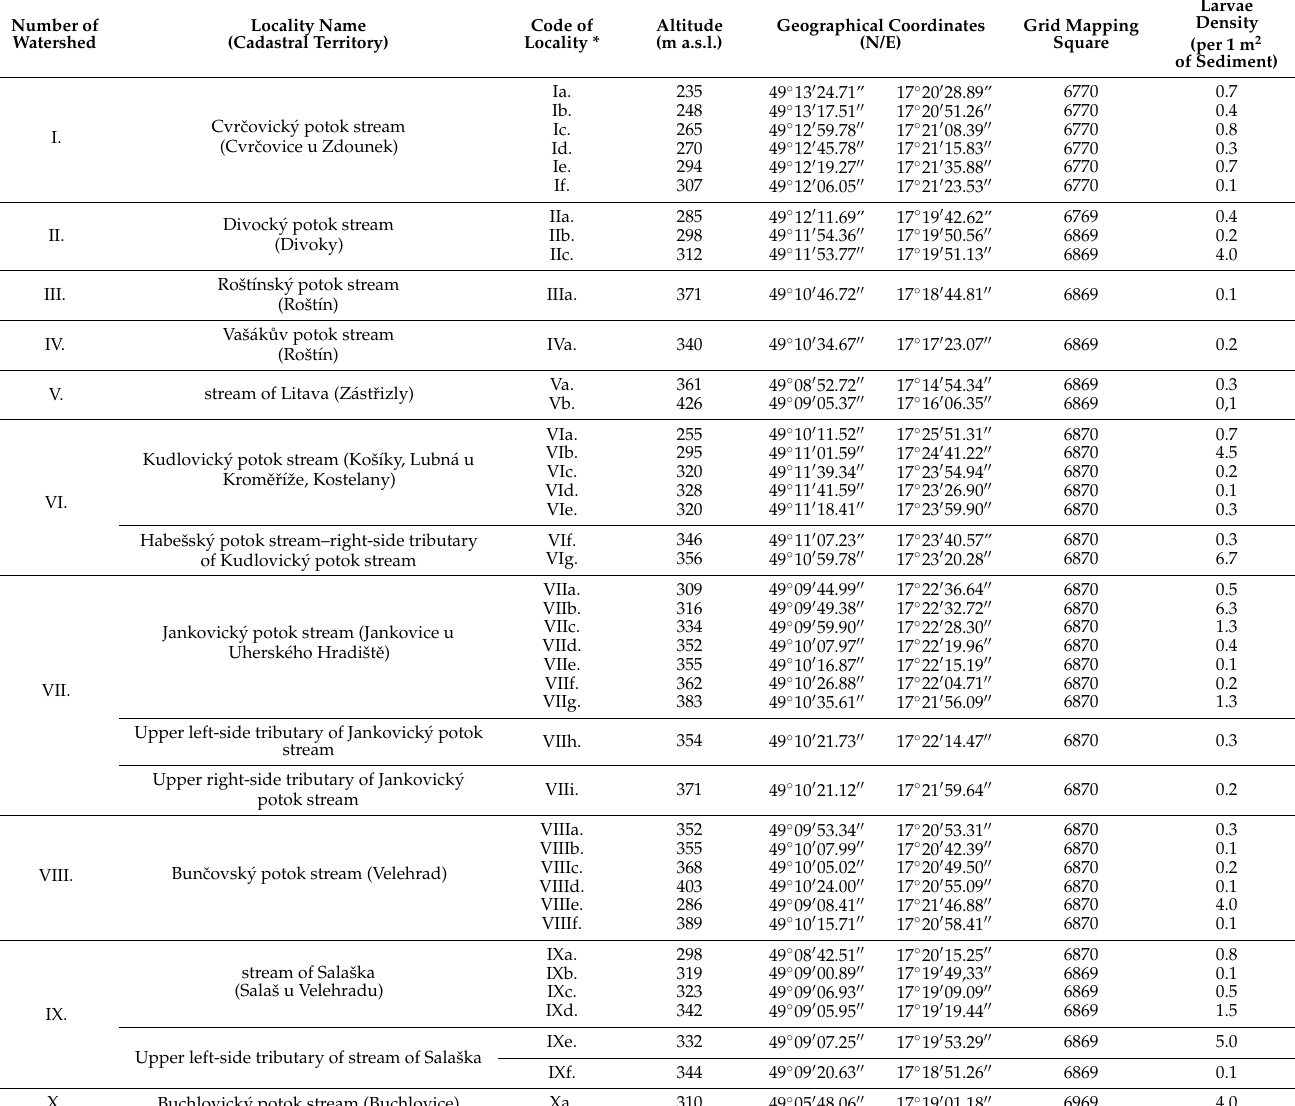
Table 1. Description of watersheds with localities with Cordulegaster heros records in the Czech Republic (only localities with detected occurrence are listed, localities are sorted